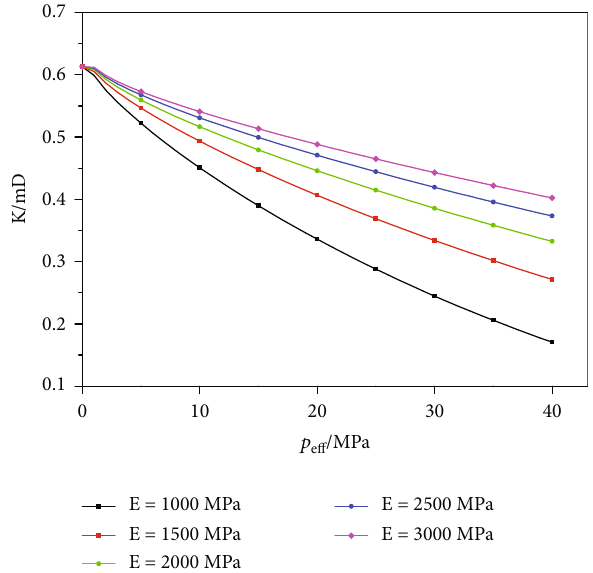
Figure 3: Relationship curve between permeability and e ff ective stress under di ff erent elastic modulus.